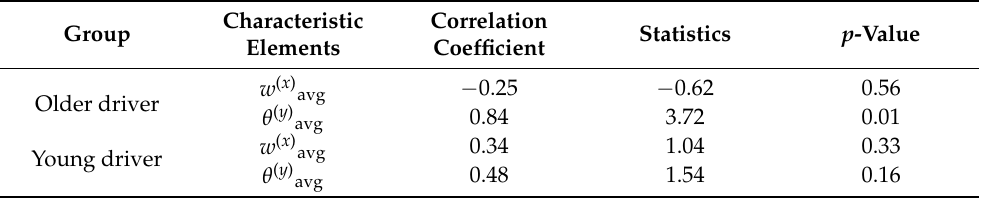
Table 13. The correlation coefficients between θ (y)avg and ω (x)avg in Experiment I and II and the left foot movement θ (y)avg and ω (x)avg in the Experiment III and